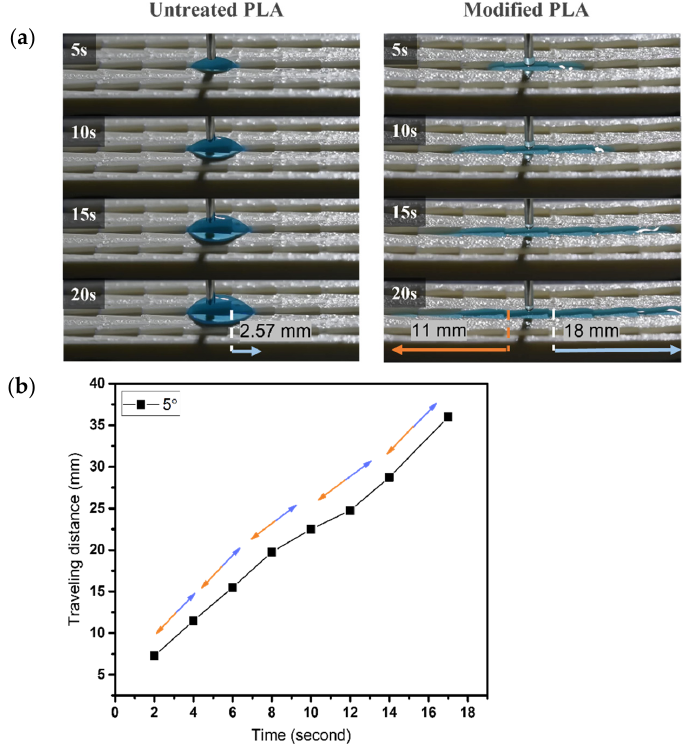
Figure 7. ( a ) The dynamic wetting behavior of water droplets in the 3D-printed dart-shaped pattern with α angle of 5 ◦ ; ( b ) Plot of traveling distance versus time with the directions of droplet movement wetting of modified pattern. The orange arrow denotes the opposite side, and the blue one denotes the predominant side.